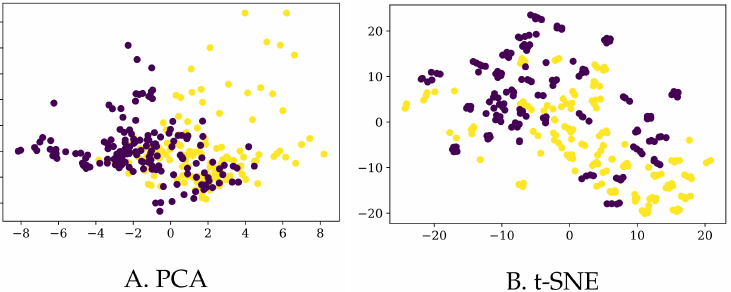
Figure 5. A 2D representation of the MedD dataset (308 points in R 42 ); in yellow, positive examples (PD patients), in purple, negative examples (participants in the HC group).